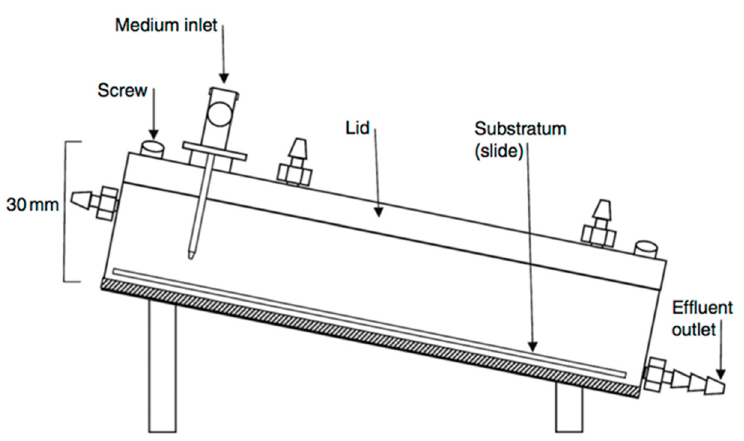
Figure 7. Schematic diagram of a drip flow biofilm reactor (adapted from McBain et al., 2009 [15], with permission from © 2009 Elsevier. License number: 4130791265178).